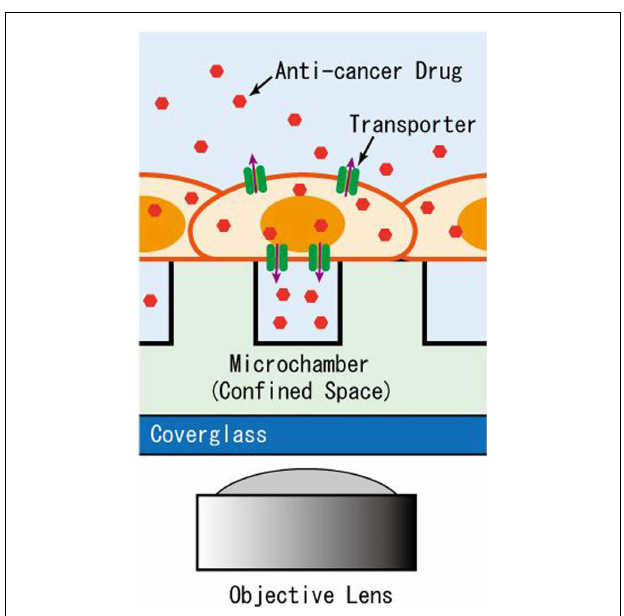
FIGURE 1 | Schematic of the microchamber system for detection of transporter activity expressed in adherent cells .The efflux of anti-cancer drug accumulates in the microchamber sealed by the intact cells for detection by